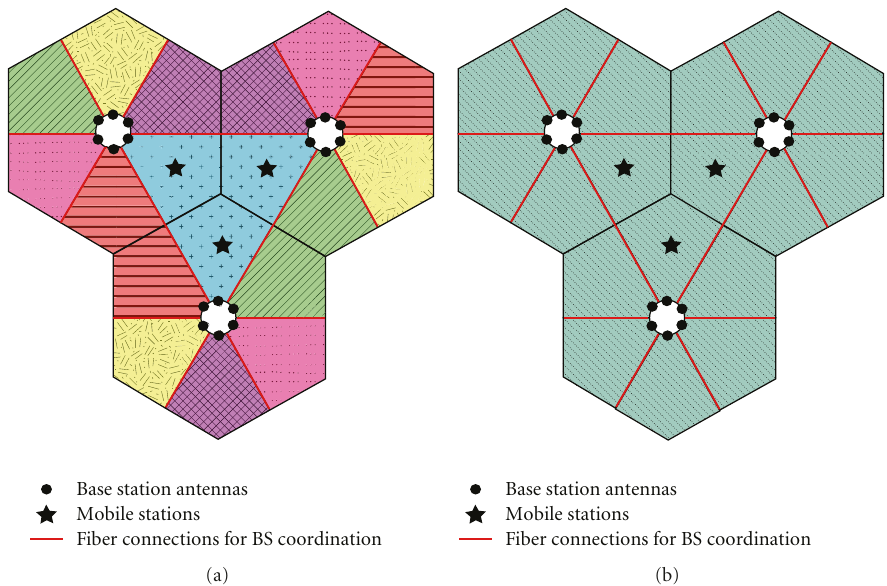
Figure 6: System models for base station coordination with (a) frequency reuse factor of 6 or (b) frequency reuse factor of 1.